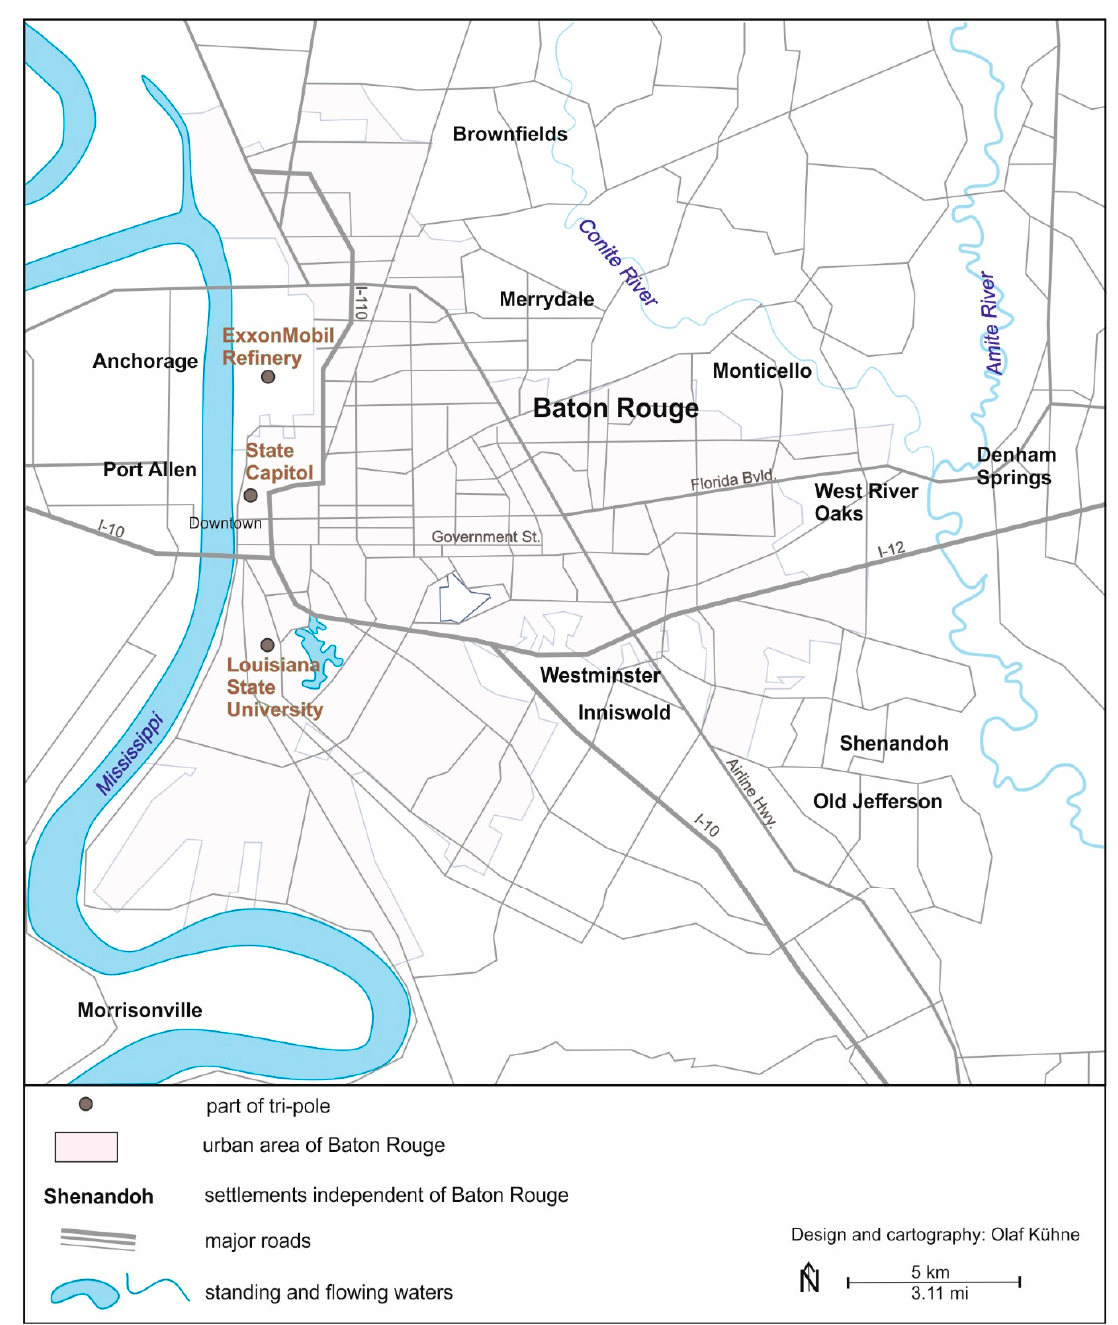
Figure 4. The three poles of development in Baton Rouge (own illustration).